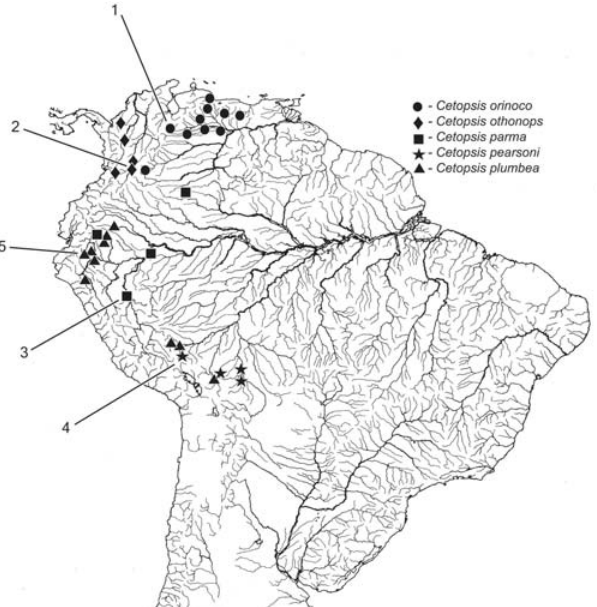
Fig. 33. Map of central and northern South America showing geographic distribution of Cetopsis orinoco (1 = holotype locality of Pseudocetopsis plumbeus orinoco ), Cetopsis othonops (2 = holotype locality of Hemicetopsis othonops ), Cetopsis parma (3 = holotype locality), Cetopsis pearsoni (4 = holotype locality), and Cetopsis plumbea (5 = lectotype locality of Cetopsis plumbeus ) (some symbols represent more that one locality and/or lot of